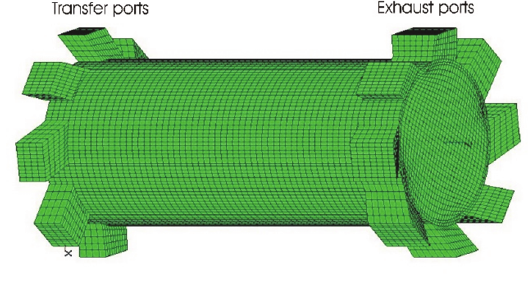
Fig. 10. Mesh of model of Leyland L60